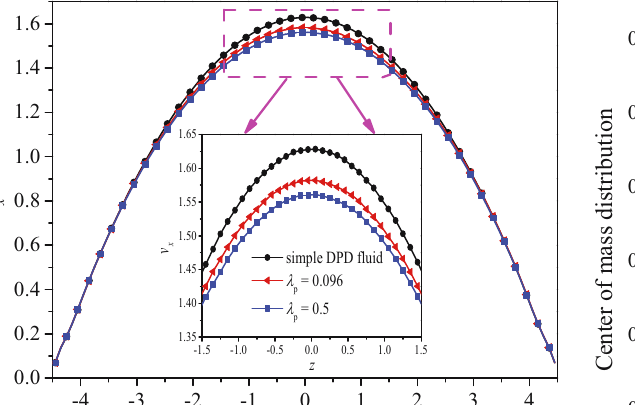
Figure 17: The wormlike chains ’ center of mass distributions